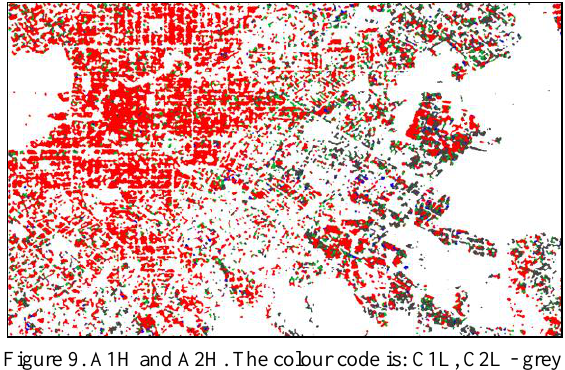
Figure 9. A1H and A2H. The colour code is: C1L, C2L - grey; C1H, C2L - green; C1L, C2H - blue; C1H, C2H - red; background (all other combinations) - white.